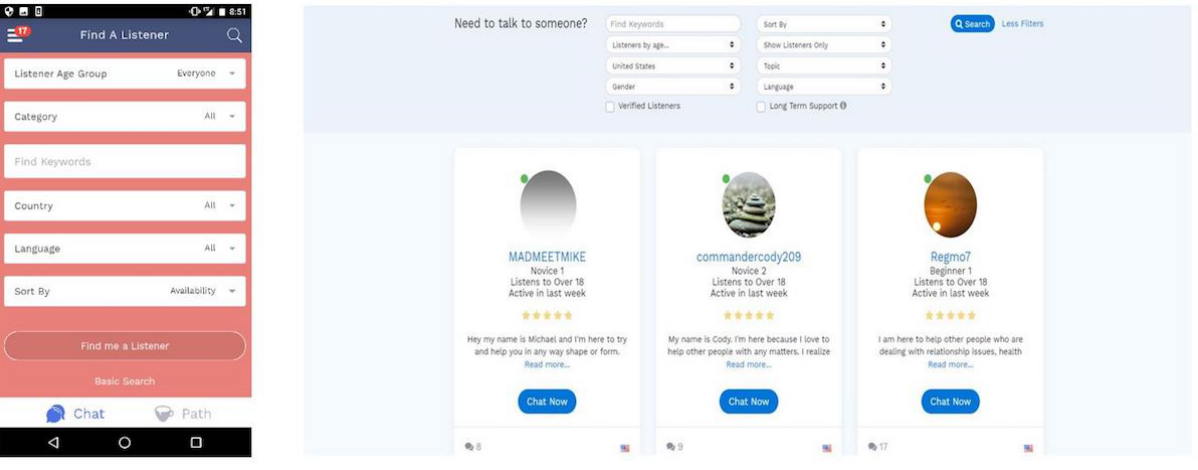
Figure 2. 7Cups Browse Listeners feature: mobile (left) and computer (right).